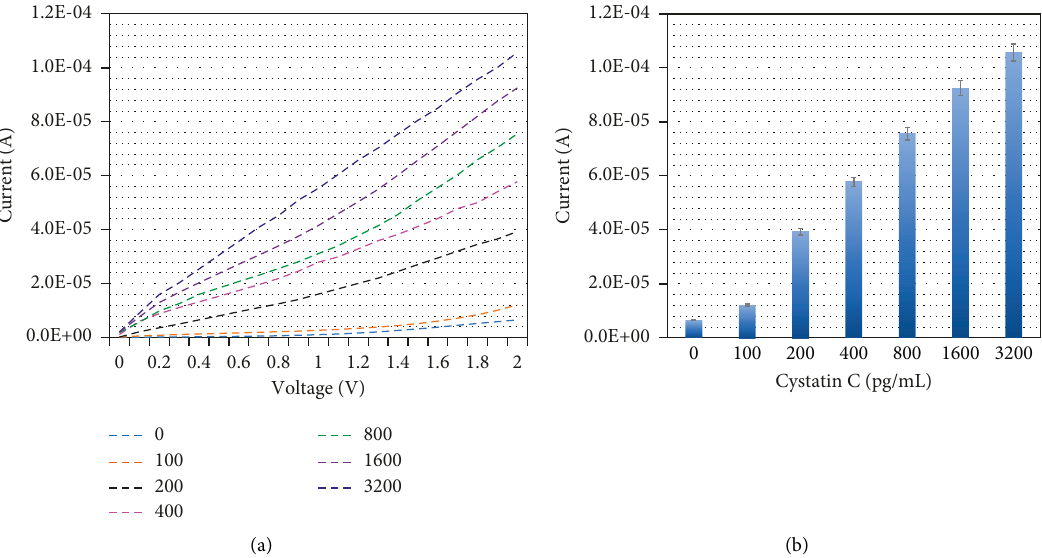
Figure 4: Detection of different concentrations of cystatin C by the immobilized papain surface. (a) The Cystatin C and papain interaction was analyzed by voltage vs current responses. The clear increment of current responses confirms the interaction of Cystatin C with the immobilized papain. (b) The current level of Cystatin C and papain interaction increases the Cystatin C concentration, and the response also increases